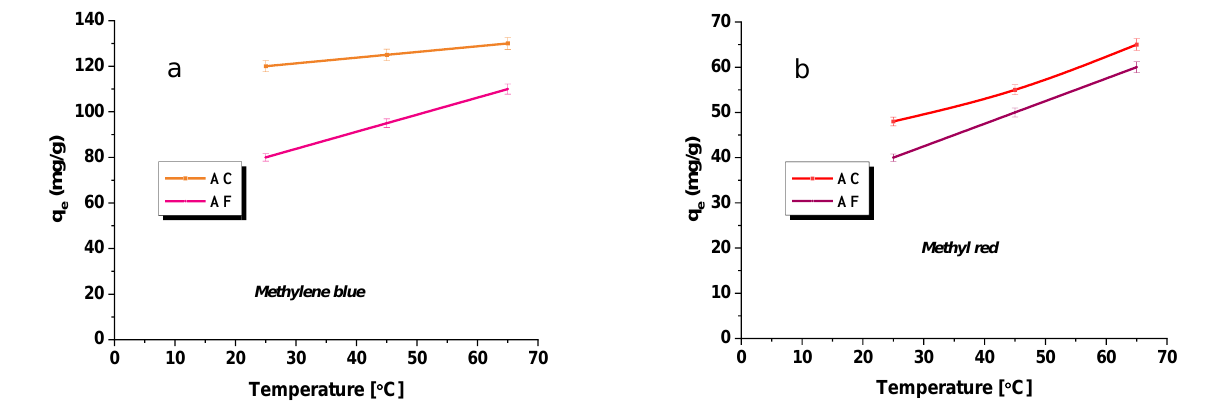
Figure 6. Effect of temperature on the adsorption of methylene blue ( a )/methyl red ( b ) on activated carbon. Table 7. Thermodynamic parameters of the adsorption of organic dyes on the activated carbon adsorbents